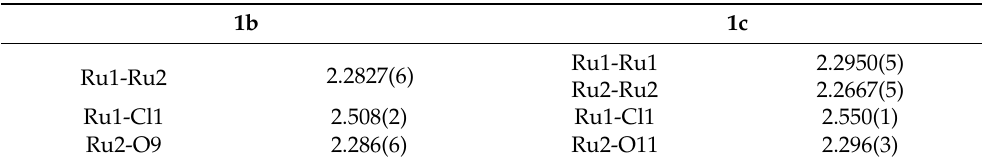
Table 2. Main bond distances (Å) in compounds 1b and 1c .